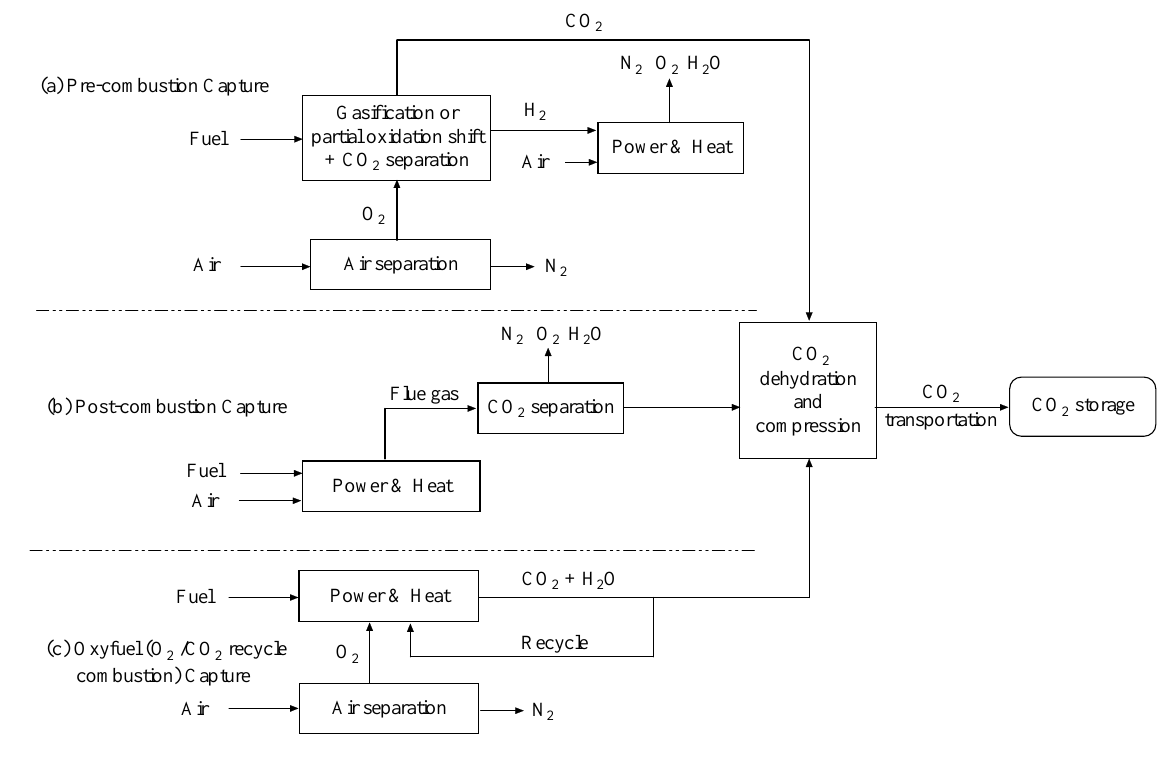
Figure 8. The chemical-looping combustion